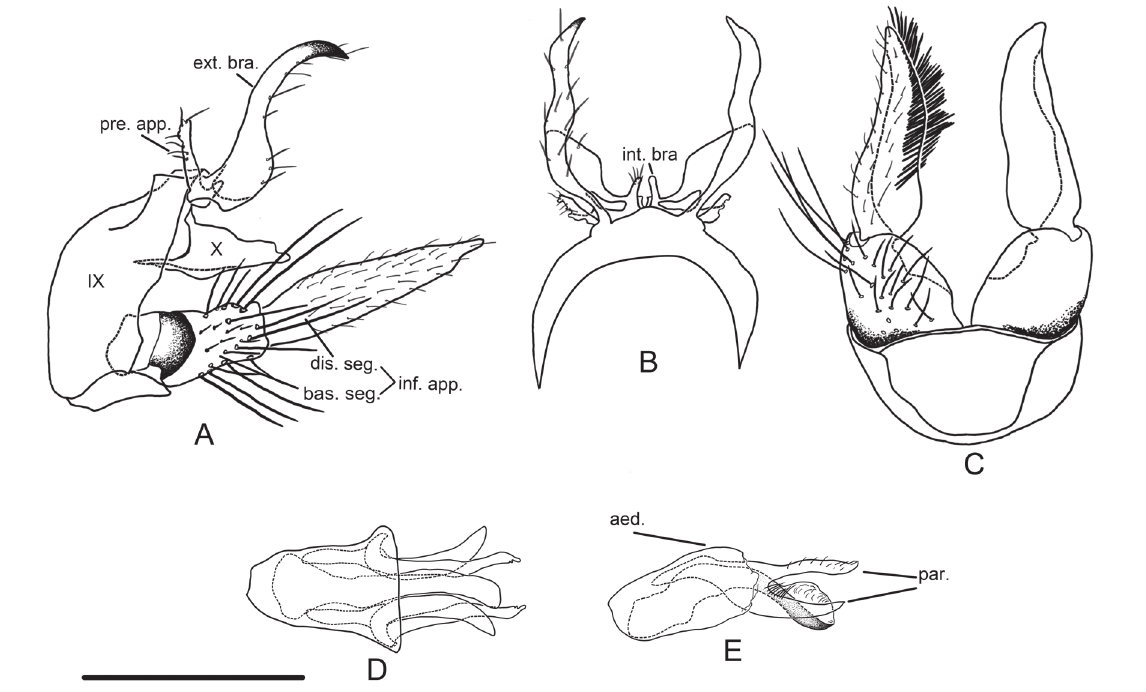
Fig. 4. Male genitalia of Apatidelia morsei Xu & Sun sp. nov. A . Lateral view. B . Dorsal view. C . Ventral view. Aedeagus. D . Dorsal view. E . Lateral view. Scale bar = 0.5 mm refers to all